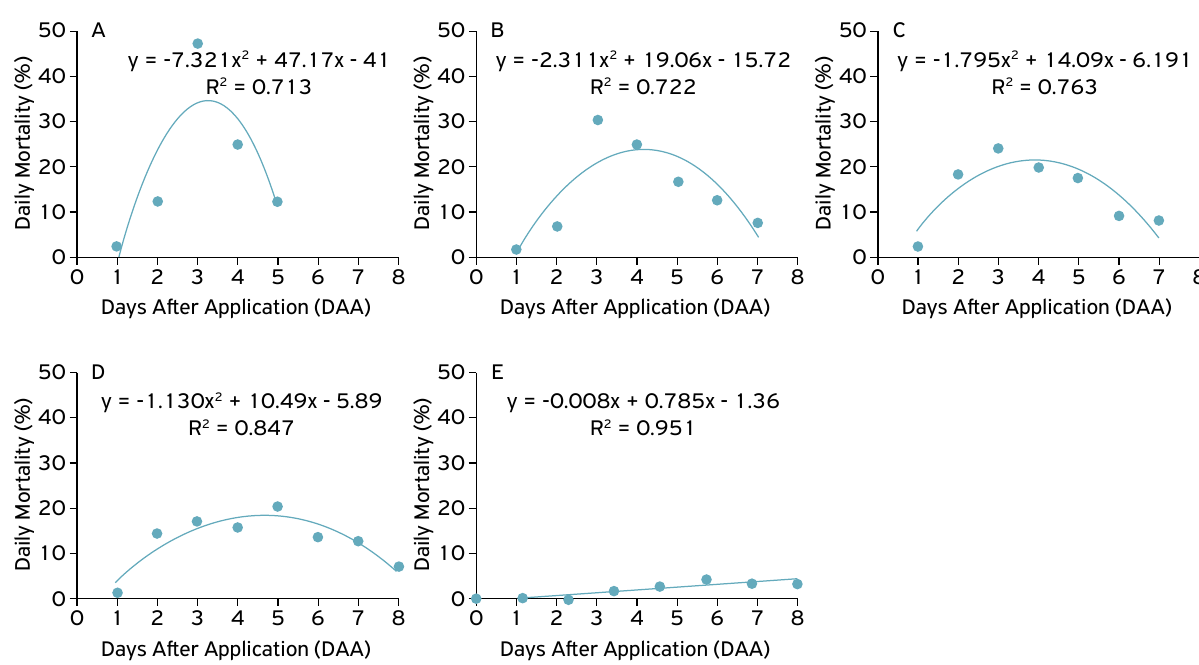
Figure 1. Daily mortality of N. viridula after application of different isolates of the M. anisopliae in the laboratory. (A) 08RA isolate; (B) 05RA isolate; (C)11RA isolate;(D) 02RA isolate;(E) Control.